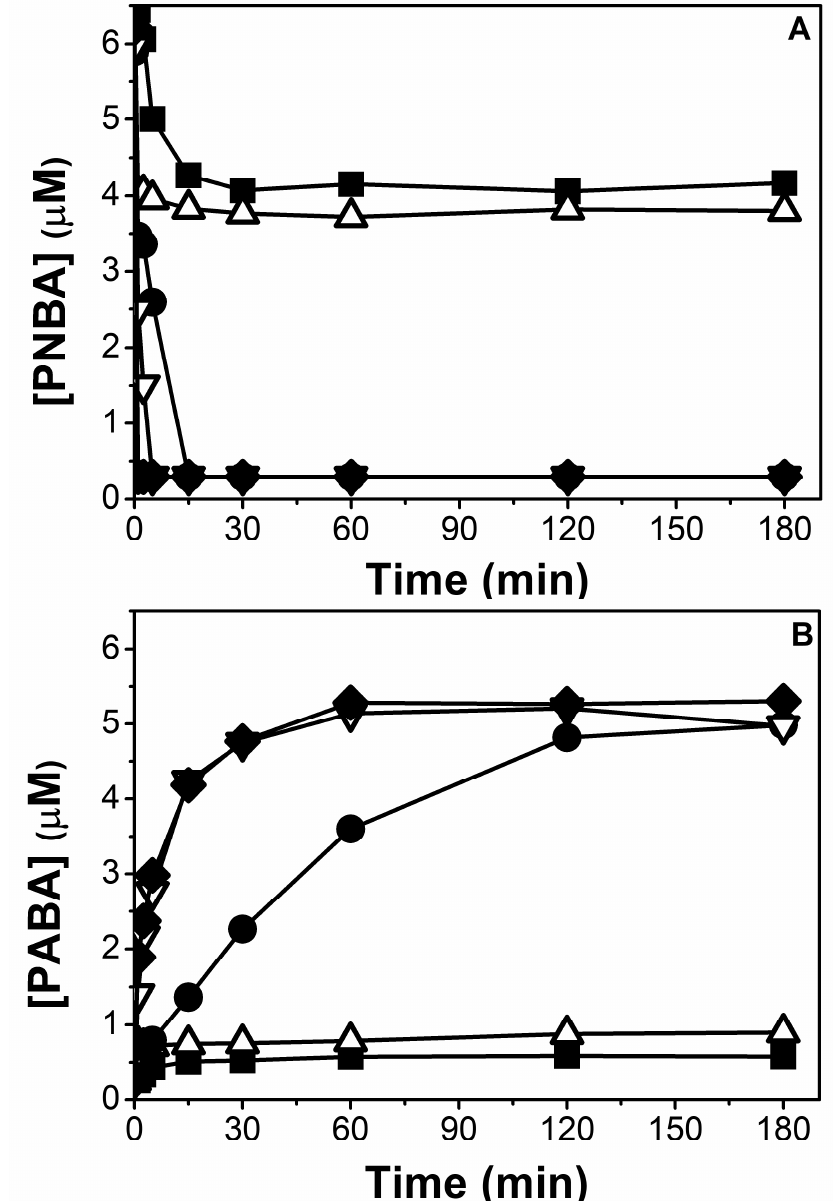
Figure 2. PNBA reduction ( A ) and generated PABA ( B ) in NW at pH 3.0 with different amounts of mZVI (g/L): 0.056 ( ■ ), 0.56 ( △ ), 1.4 ( ● ), 2.8 ( ▽ ) and 4.2 ( ◆ ).